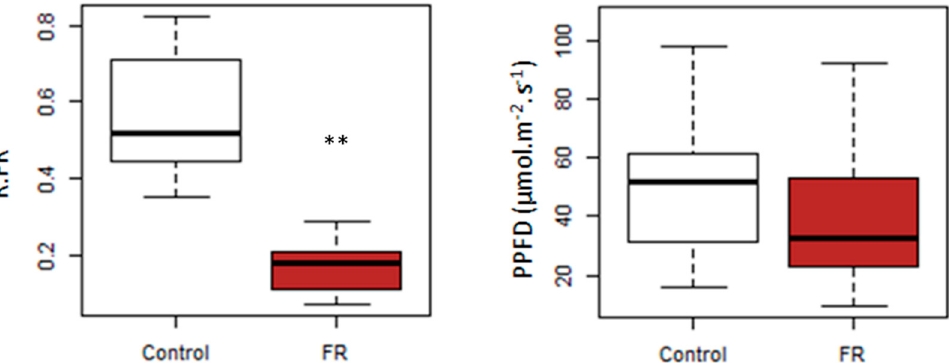
Figure 2. R:FR in Transmitted light ( left ) and PPFD in Transmitted light ( right ) measured at solar stem base of the control plants (white) and the FR plants (brown). Kruskal–Wallis test, ** p < noon on 7 May at the stem base of the control plants (white) and the FR plants (brown). Kruskal– Wallis test, ** p < 0.01.